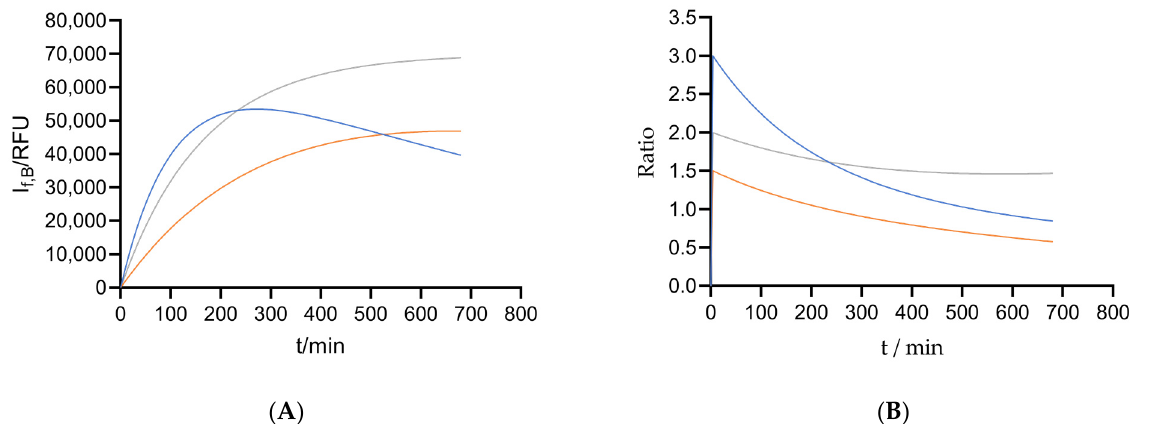
Figure 1. Fitting curves of the data presented by Uzarski et al. [7] on the reducing power of three different cell lines (panel A -TK188 fibroblasts, grey; Distal MDCK cells, blue; Proximal RPTE cells, orange) and ratio of the fitted curves obtained with any two out of the three cell lines (panel B - MDCK/RPTE, blue; MDCK/TK188, orange; TK188/RPTE, grey). For the fitted curves in panel A, k 2 / k 1 was 0.11, 0.20 and 0.00 for MDCK, RPTE and TK188, respectively. [A]( t = 0) was set equal for the three cell lines. Aditional data can be found in reference [7].